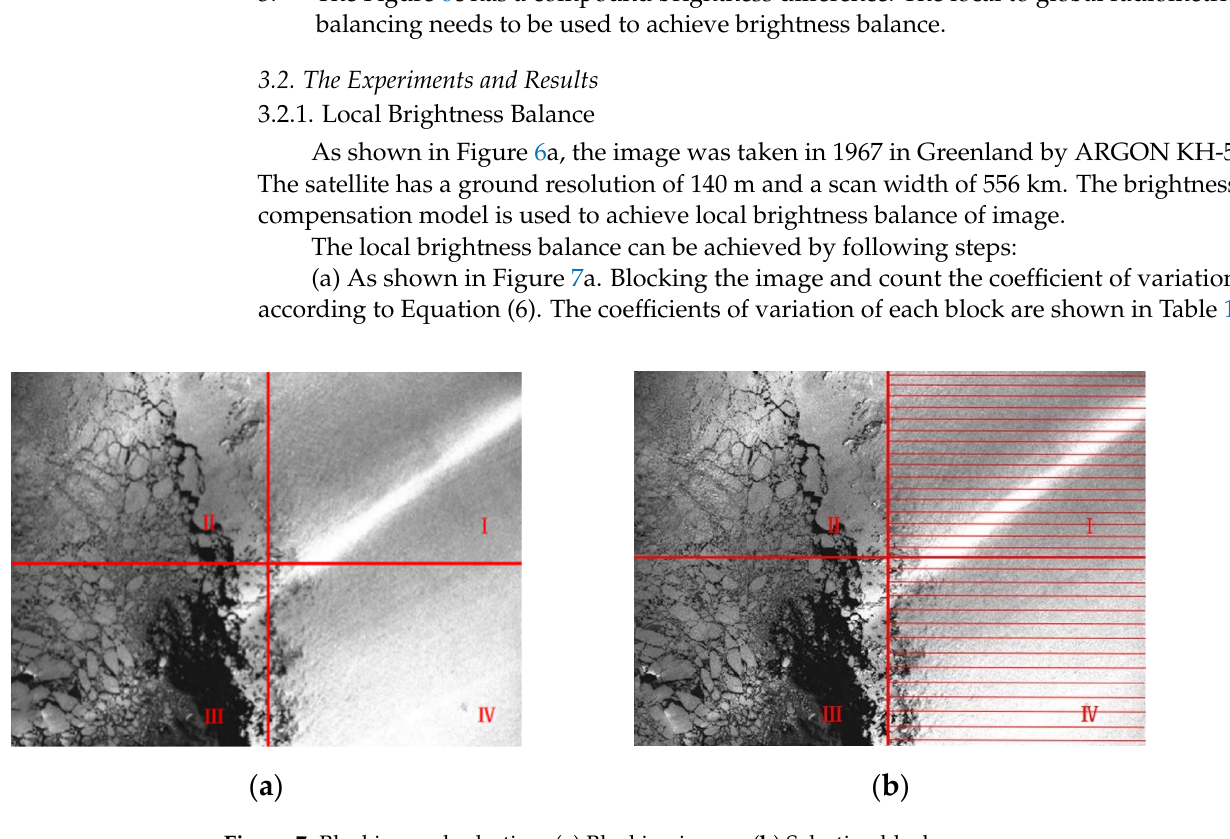
Table 1. The coefficients of variation of each block.